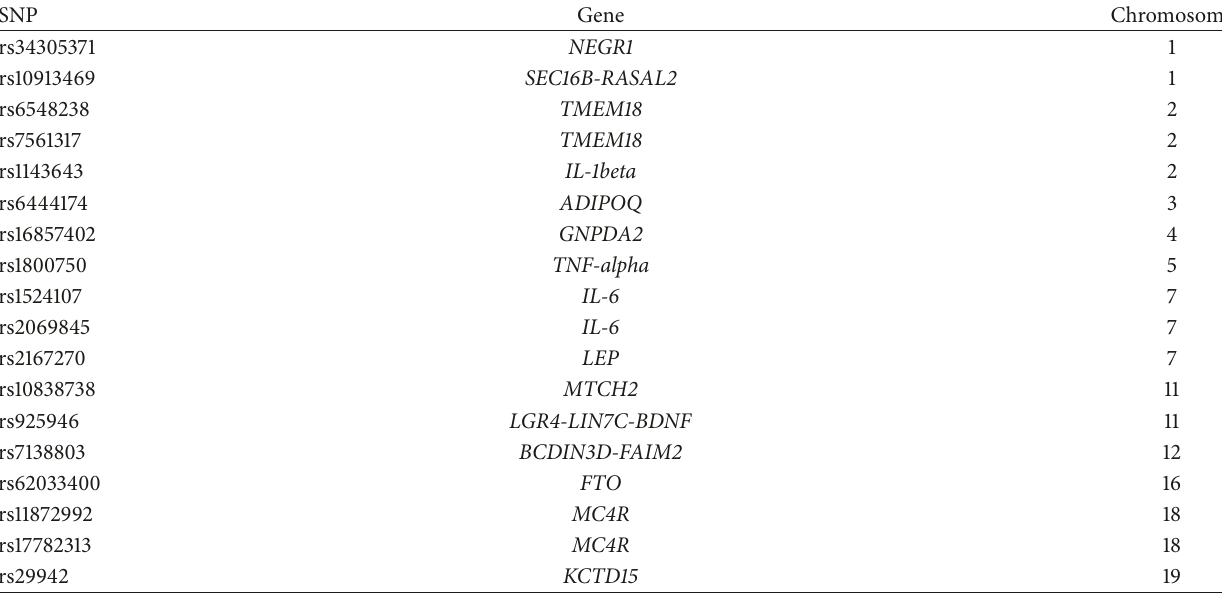
Table 1: Single nucleotide polymorphisms evaluated in this